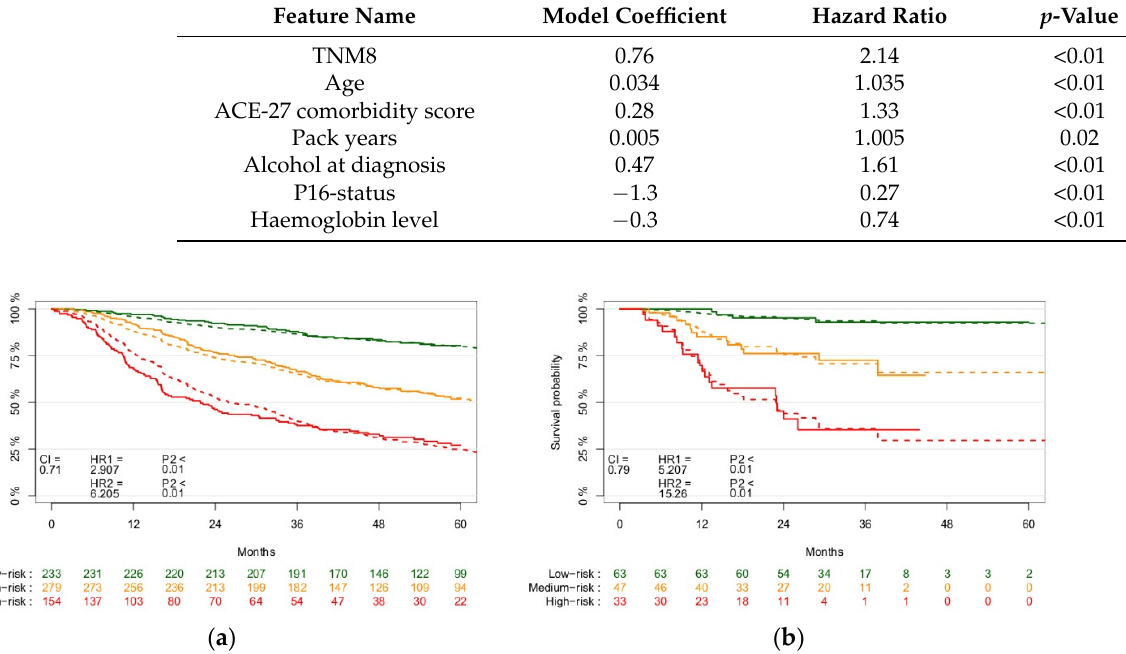
Figure 4. Kaplan–Meier survival cohorts of the training (( a ), n = 666) validation (( b ), n = 143) patient cohorts stratified into low-, medium-, and high-risk groups based on radiomics, tumour volume, clinical, and biological parameters, showing the p -value of the split between risk groups and CI of the model performance. The solid lines represent the observed survival curves, and the dashed line the corresponding predicted survival curves. Table 2. Selected clinical and biological features in the clinical, biological, and combined models, with univariate model coefficient, hazard ratio, and significance to outcome shown.